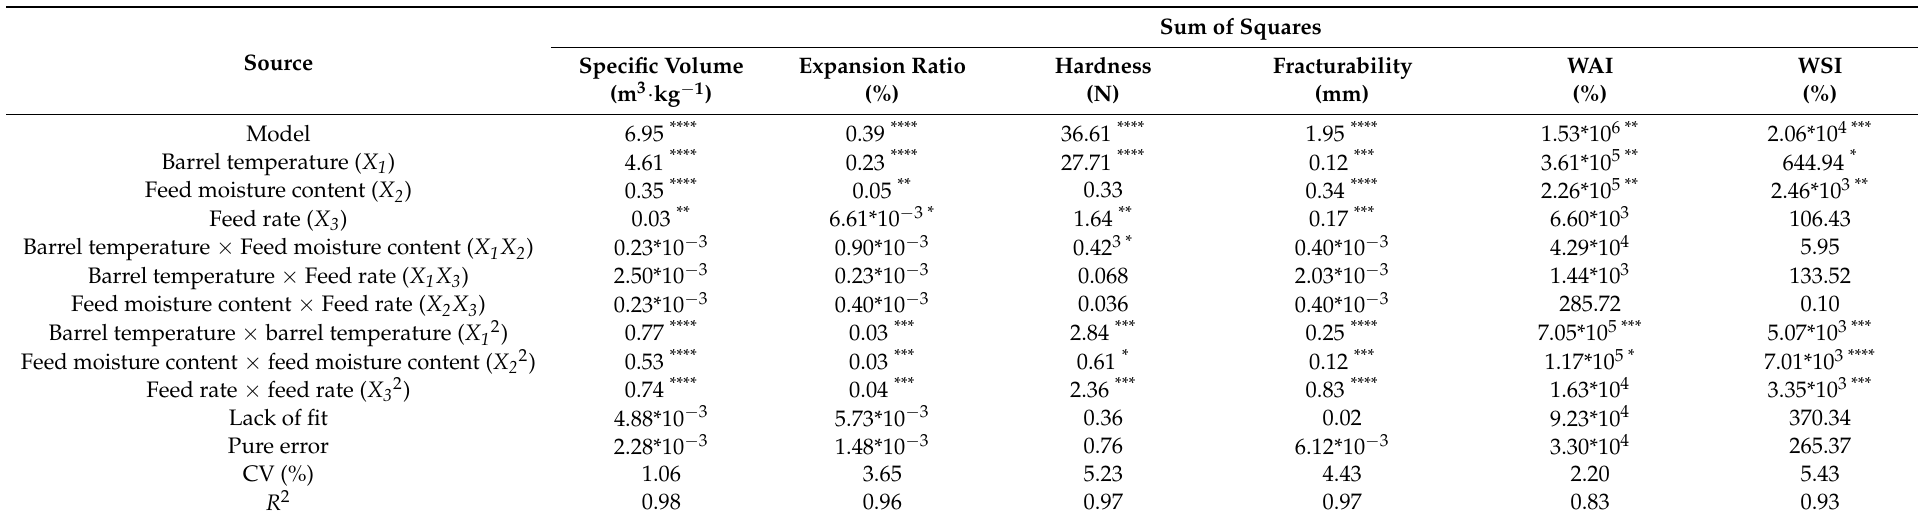
Table 8. ANOVA of the different models of the responses of the whole BGW